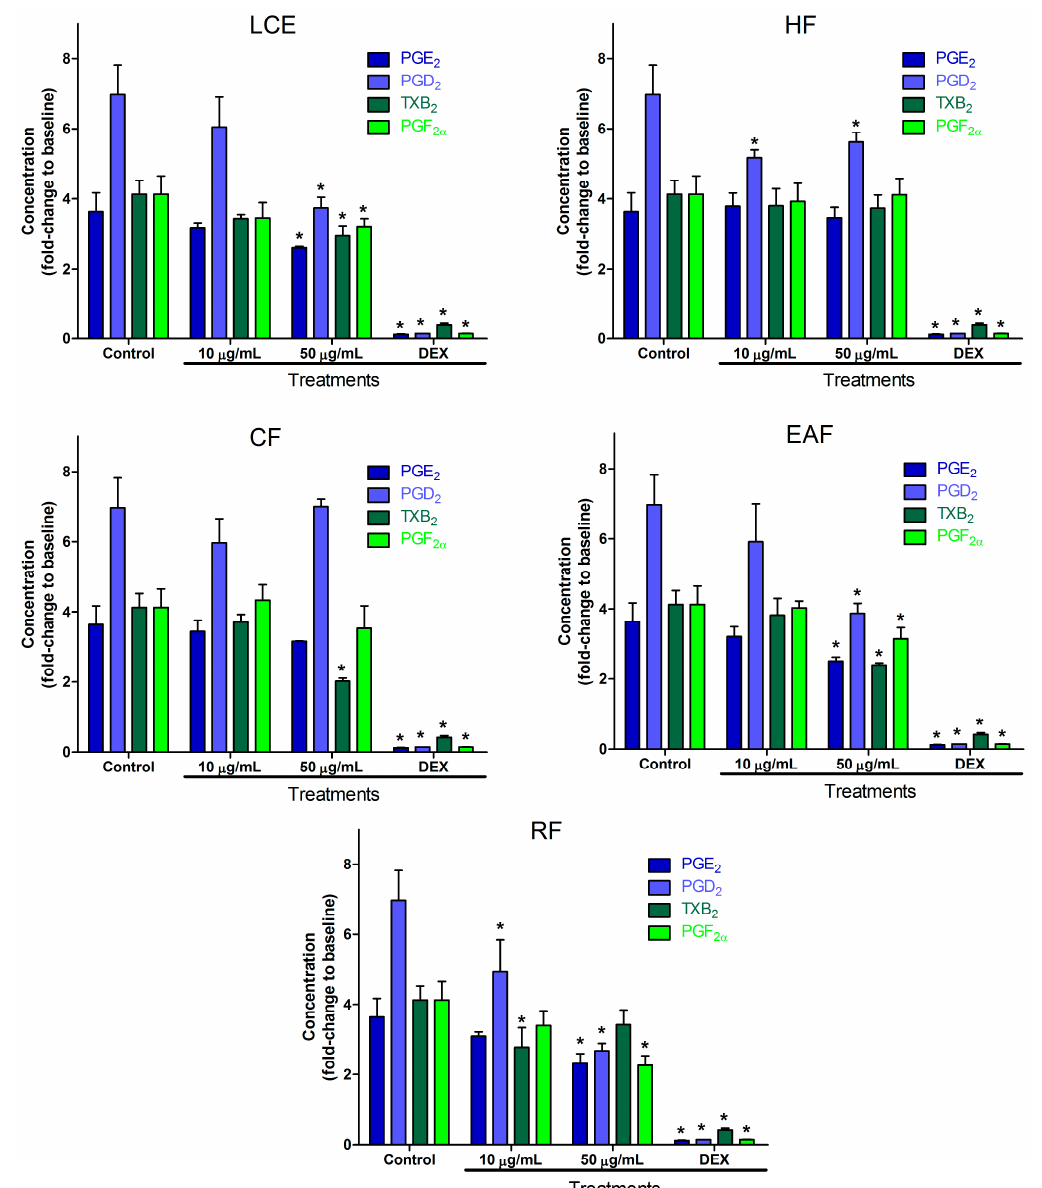
Figure 3. Effect of leaf crude extract, hexane fraction, chloroform fraction, ethyl acetate fraction, and residual fraction of P. graveolens on PGE 2 , PGD 2 , TXB 2 , and PGF 2 α production in LPS-stimulated RAW 264.7 cells. Cells were treated with LPS in the absence or presence of the fractions at two concentrations (10 and 50 µ g/mL). DEX was used as positive control. After incubation, cell culture supernatants were harvested, and PGE 2 , PGD 2 , TXB 2 , and PGF 2 α production was determined. Values are expressed as mean ± SD. * p < 0.001 vs. control (LPS alone).